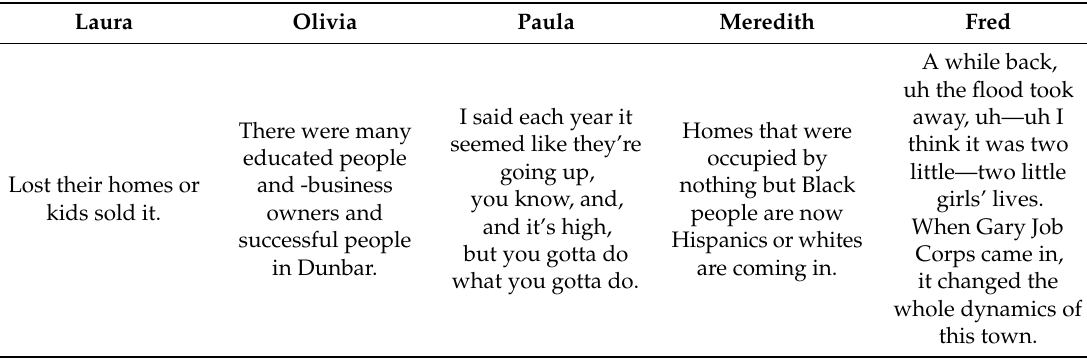
Table 3. Emergent Themes for Impact of Environmental and Social